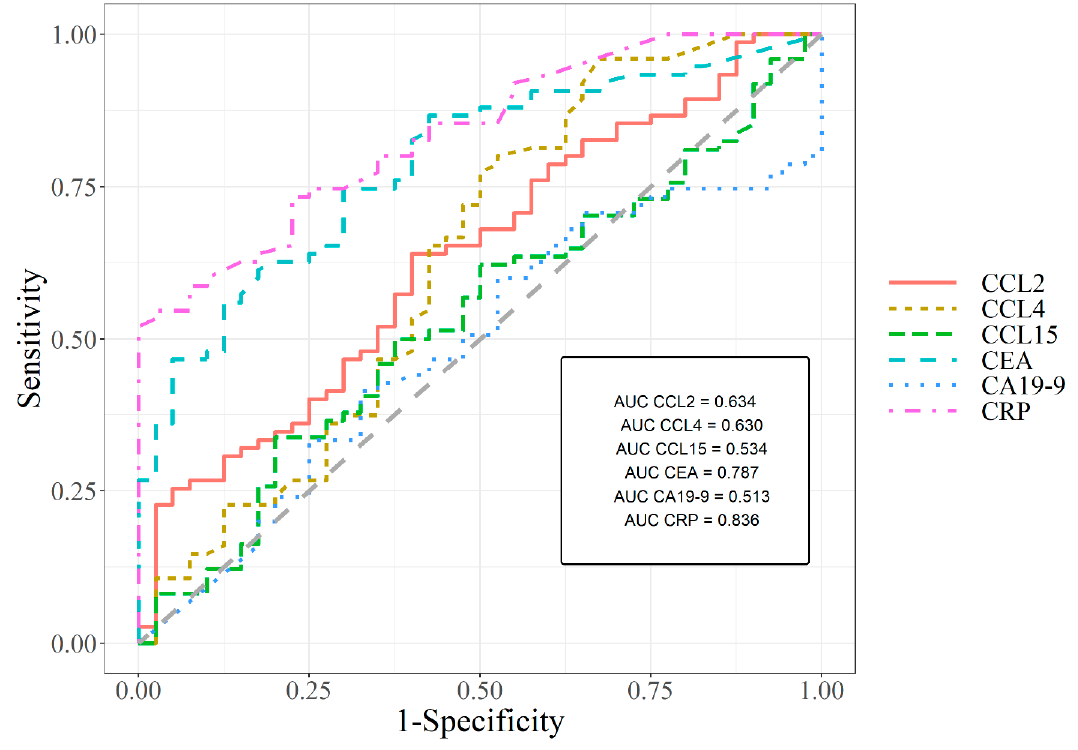
Figure 1. Receiver operating characteristics for all significant ROC analysis results. Table 6. Spearman’s rank correlation coefficient for tested